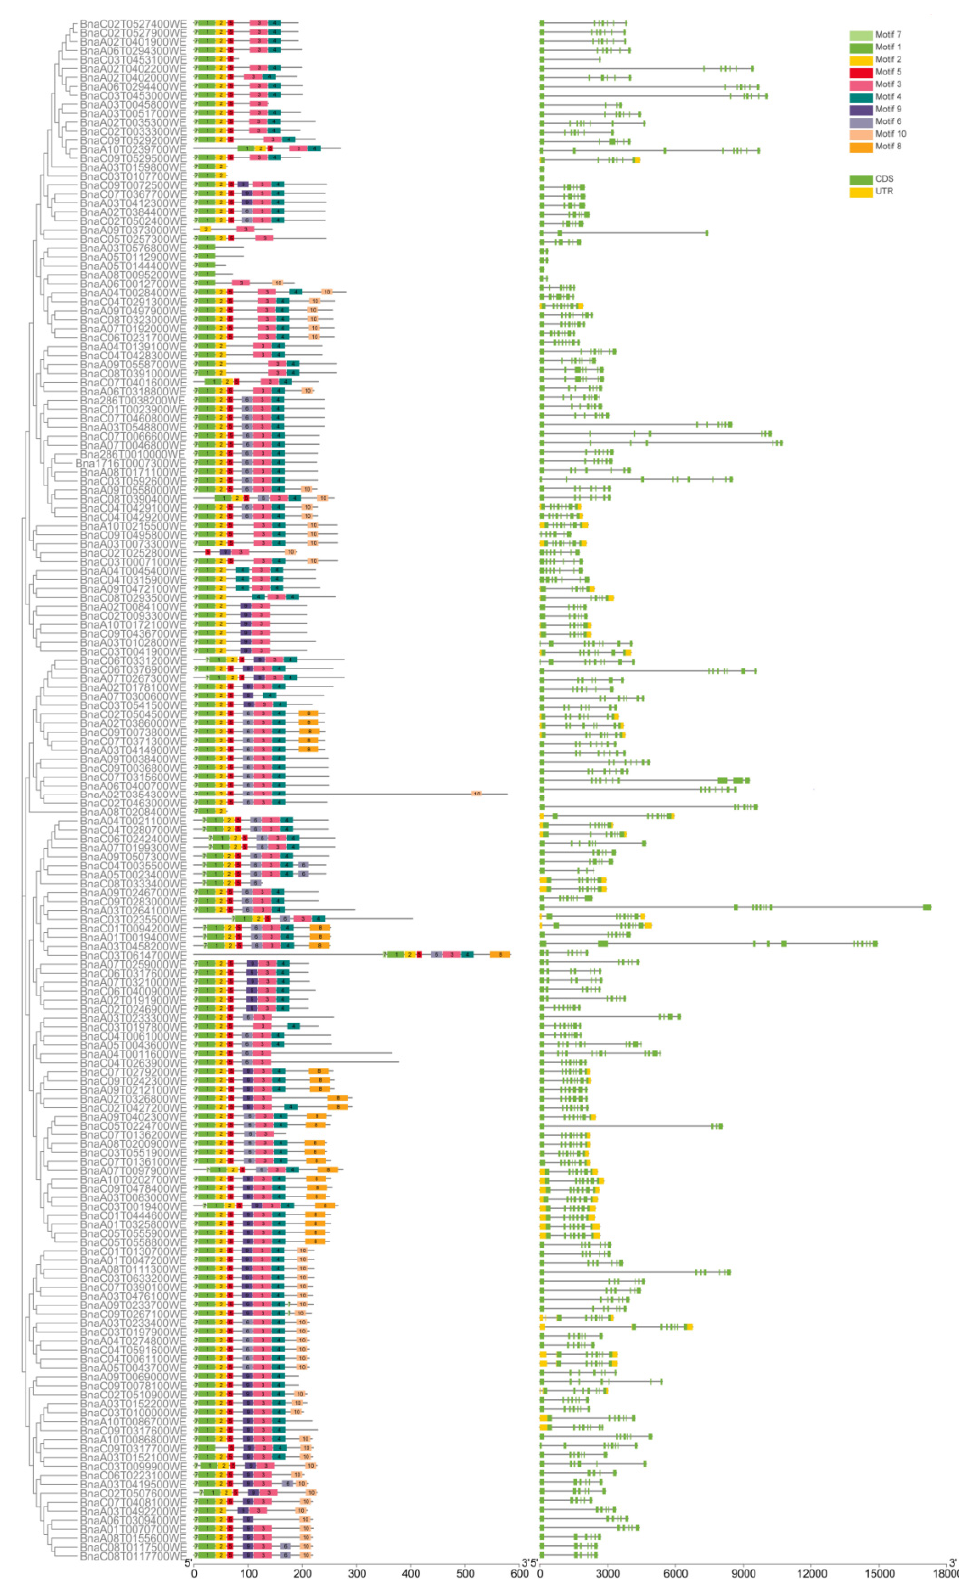
Figure 4. Motif and gene structure analysis of the MIKC family members.